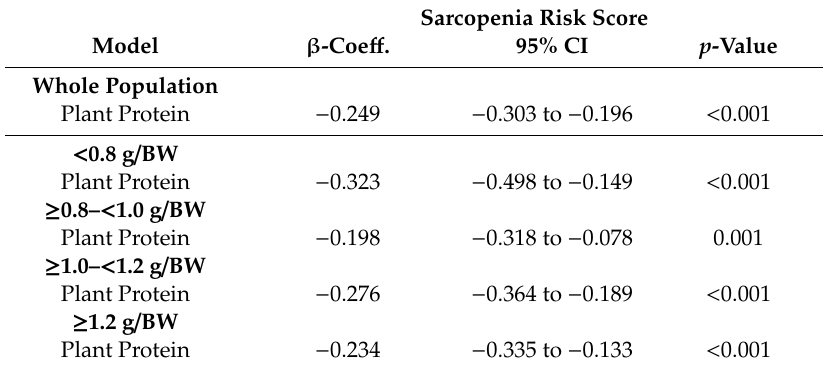
Table 3. Isocaloric substitution of animal-based protein with plant-based protein on sarcopenia